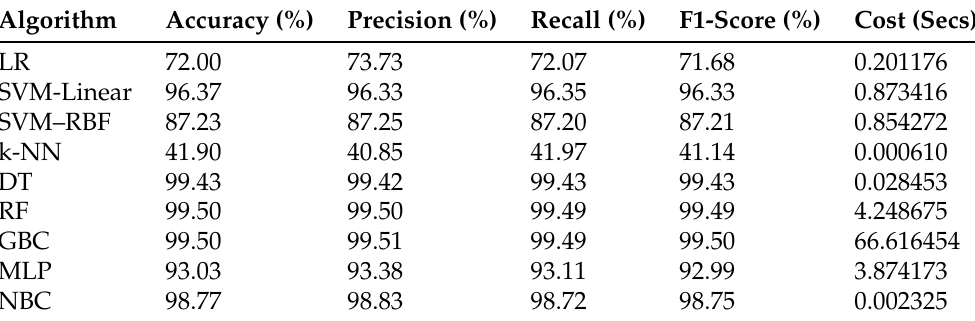
Table 5. Global performance comparison of ML